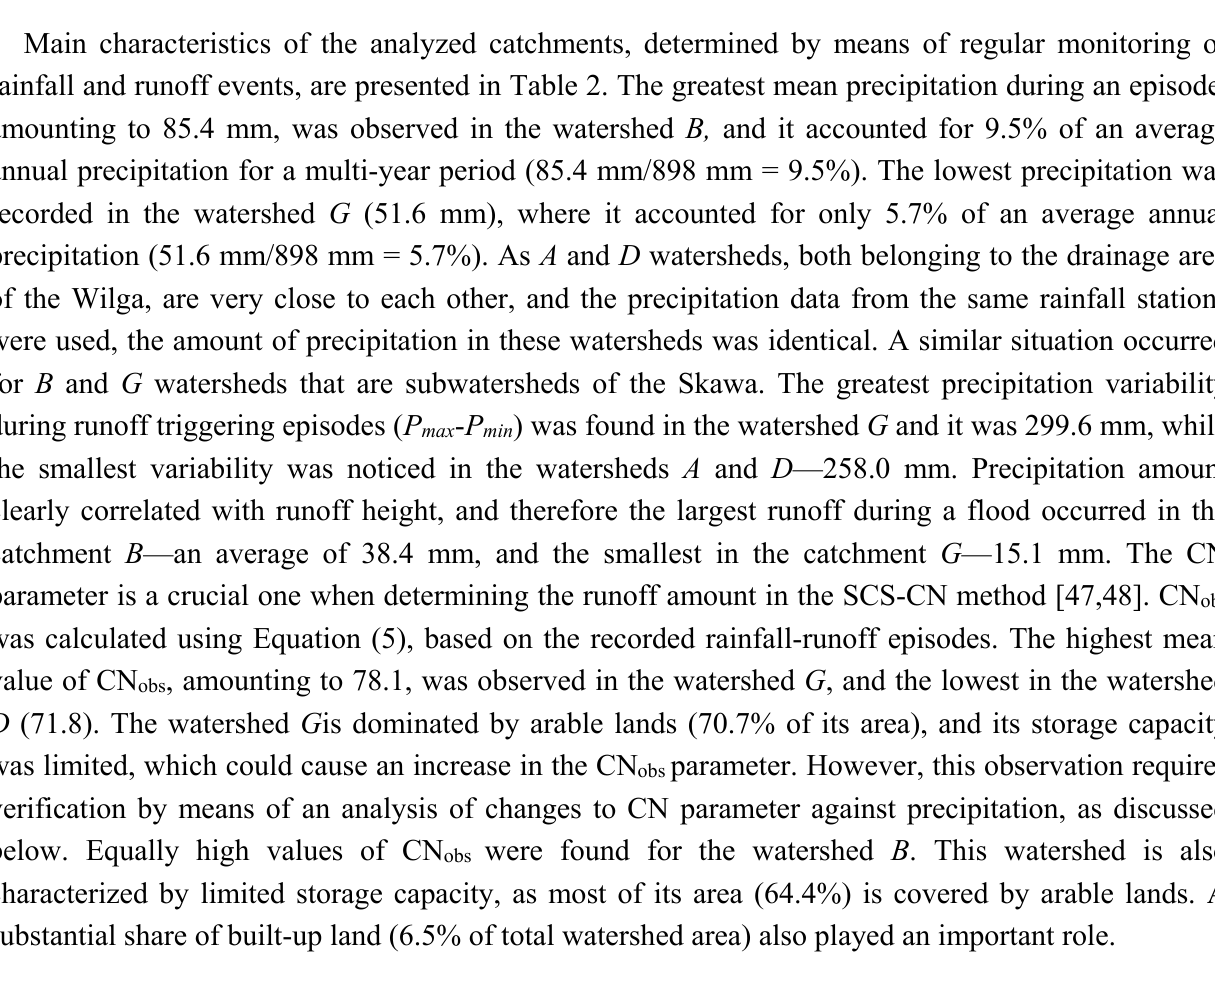
Table 2. Characteristics of the rainfall-runoff events for all